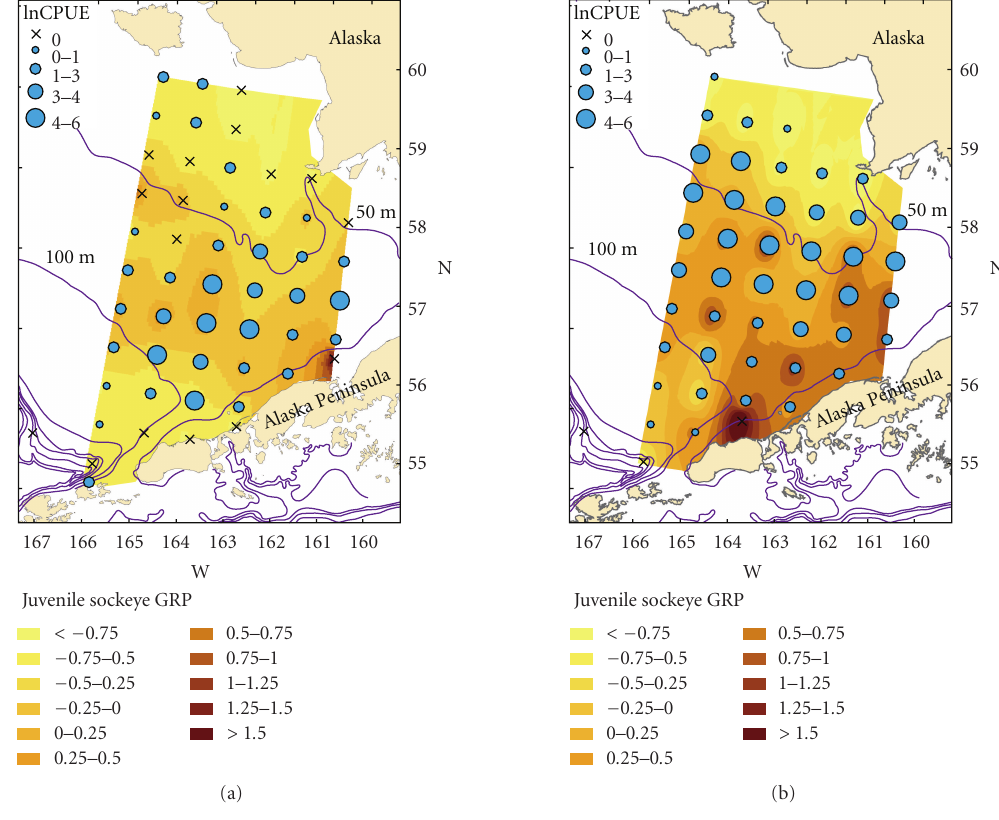
Figure 3: (a) Contour plot of the average juvenile sockeye salmon growth rate potential (GRP—% body weight per day) in relation to the natural logarithm of catch per unit e ff ort of juvenile sockeye salmon capture during cooler years (2000, 2001, and 2006). (b) Contour plot of the average juvenile sockeye salmon growth rate potential (GRP—% body weight per day) in relation to the natural logarithm of catch per unit e ff ort of juvenile sockeye salmon capture during warmer years (2002 to 2005).